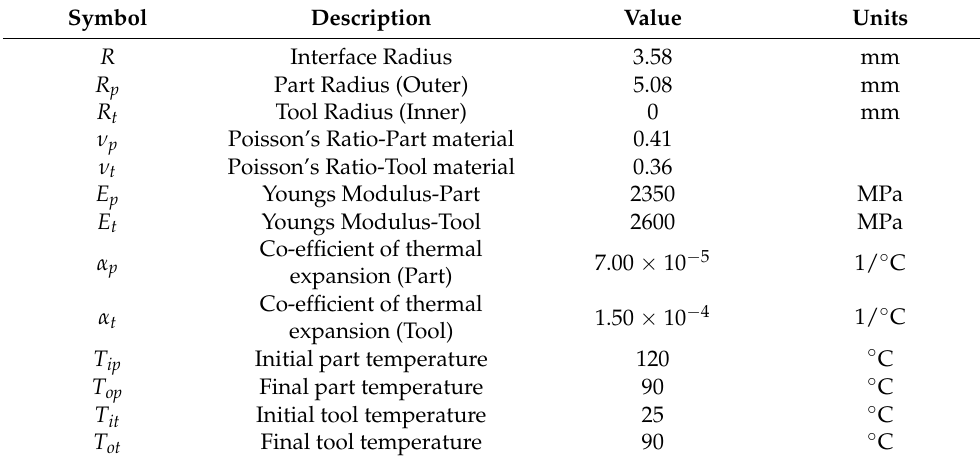
Table 6. Description of the input variables and values for M5 core